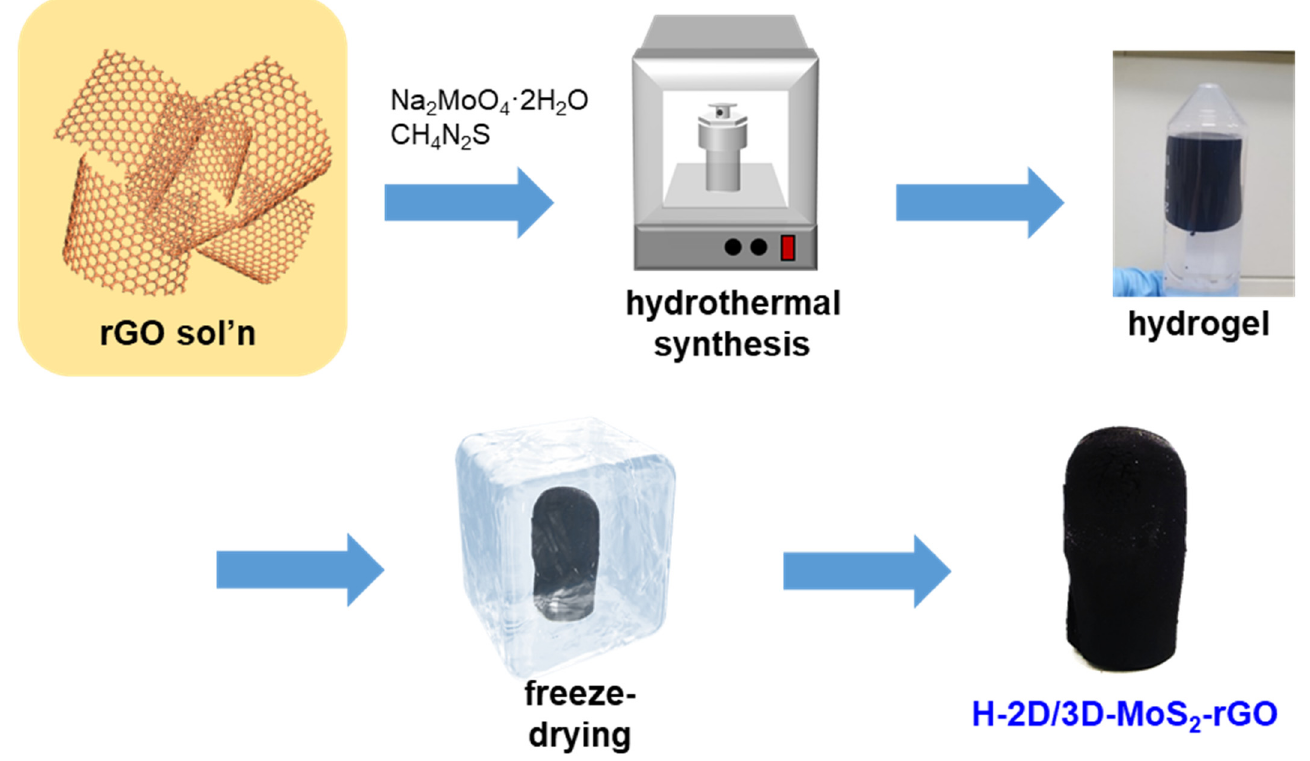
Figure 1. Schematic of the synthesis process for the H-2D/3D-MoS 2 -rGO structures.